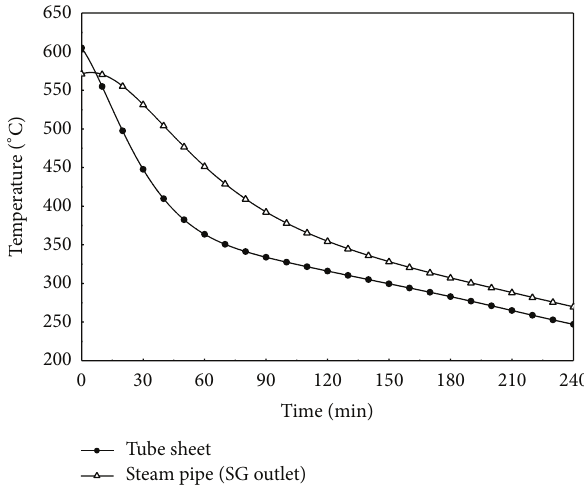
Figure 10: Temperature variation of SG outlet during precooling using steam as coolant; steam temperature: 190 ∘ C; pressure: 1.0 MPa; and flow rate: 0.74 kg/s.